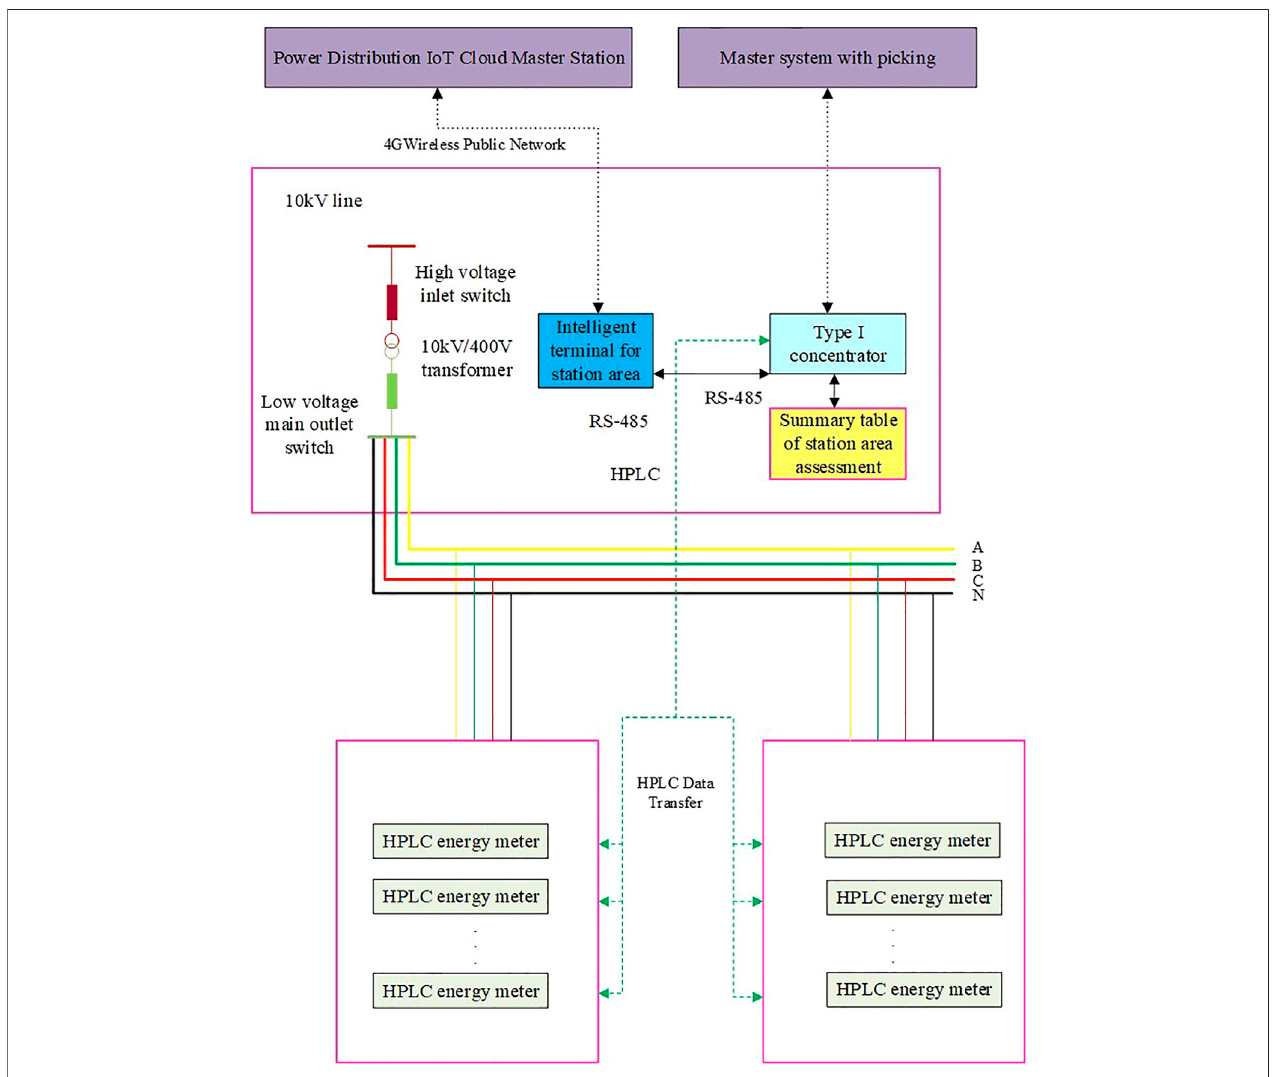
FIGURE 4 | Scheme 2 interaction